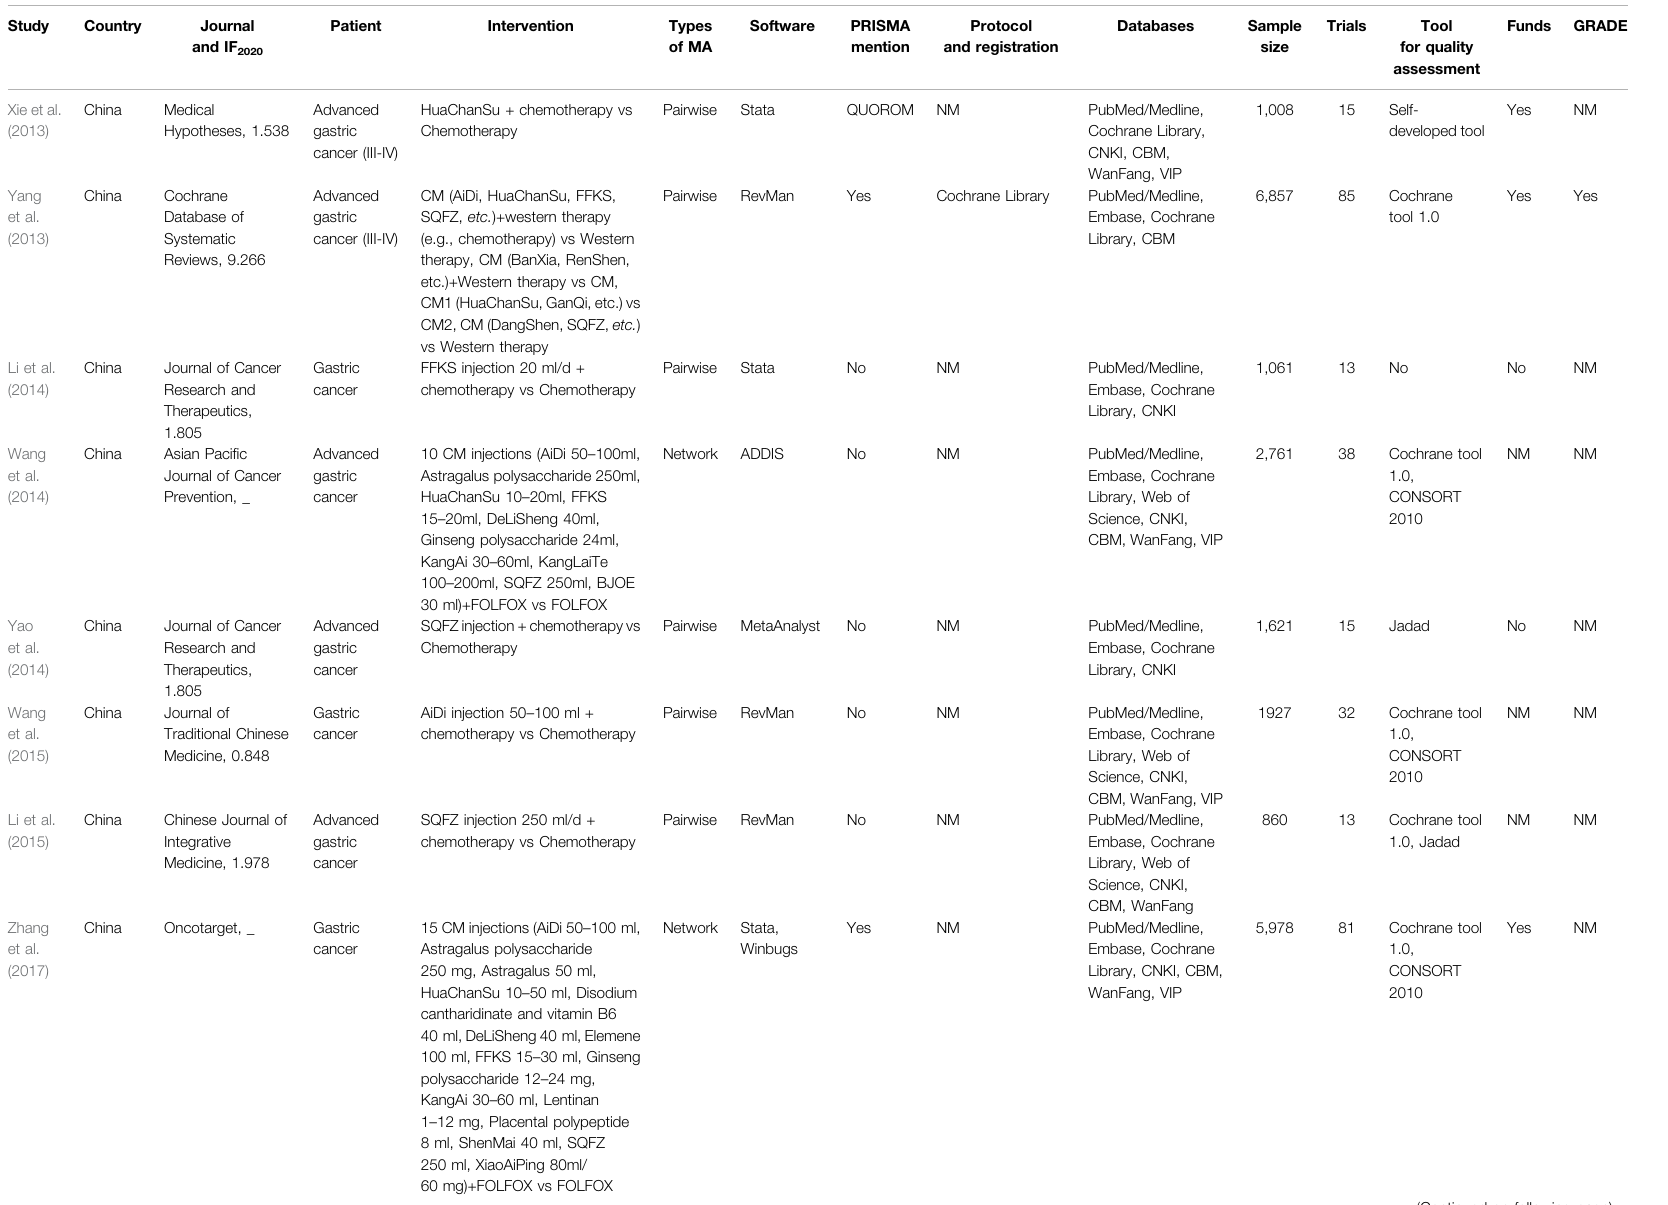
TABLE 1 | Basic characteristics of the included